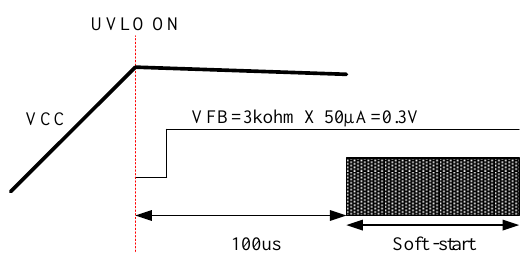
Figure 12. Embedded logic circuit for adjusting the frequency swapping range. Table 1. Comparison of swapping range settings.